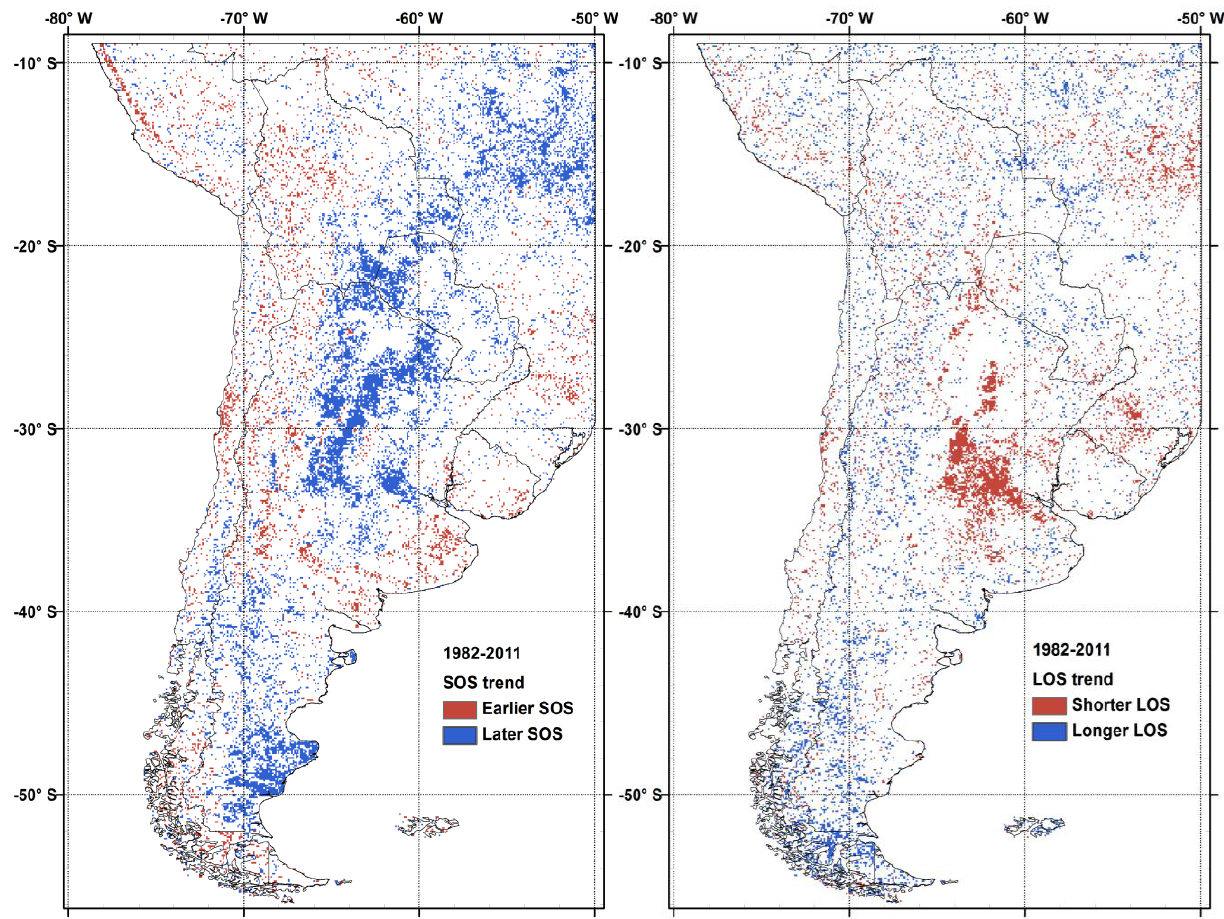
Figure 9. Thirty-year significant trends ( p ≤ 0.05) in the SOS and LOS indicating regions where SOS is earlier or later and where the LOS is longer or shorter. Many of these shifts span 30 to 90 days over 30 years, but are often very variable from year to